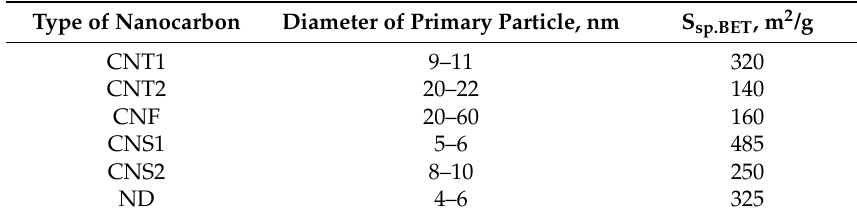
Table 6. Texture characteristic of